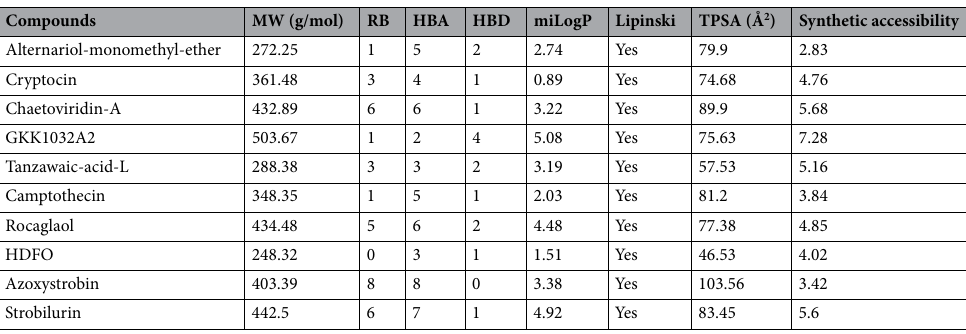
Table 3. Physicochemical properties of selected potential compounds and reference fungicide compounds. MW molecular weight, RB rotatable bond, HBA hydrogen bond acceptor, HBD hydrogen bond donor, TPSA topological surface area.